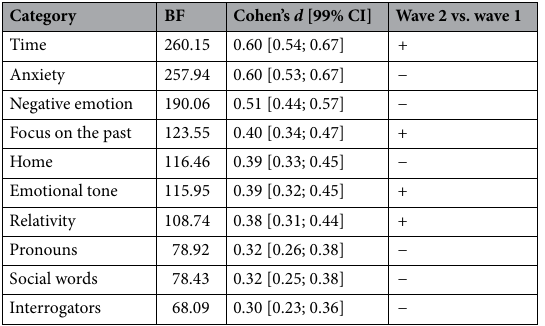
Table 6. The 10 most changed LIWC categories in long texts (ranked by